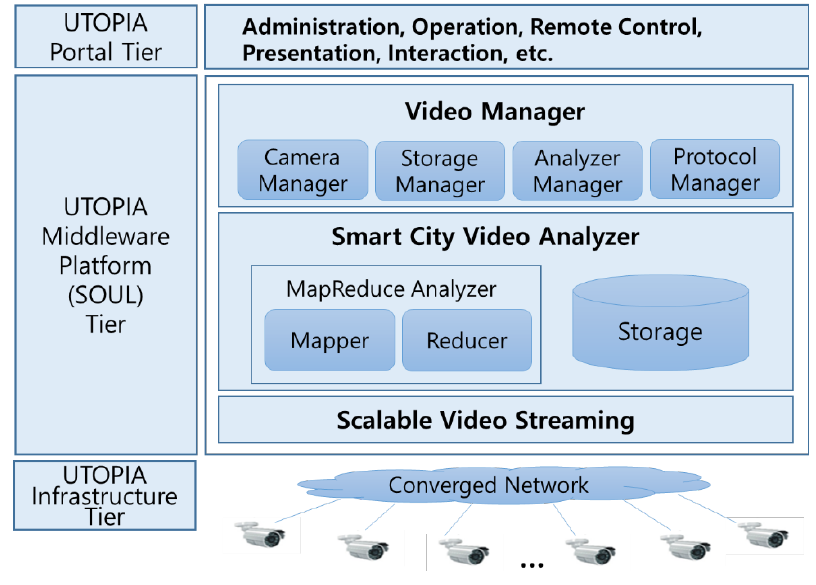
Figure 2. The architecture of USVS.